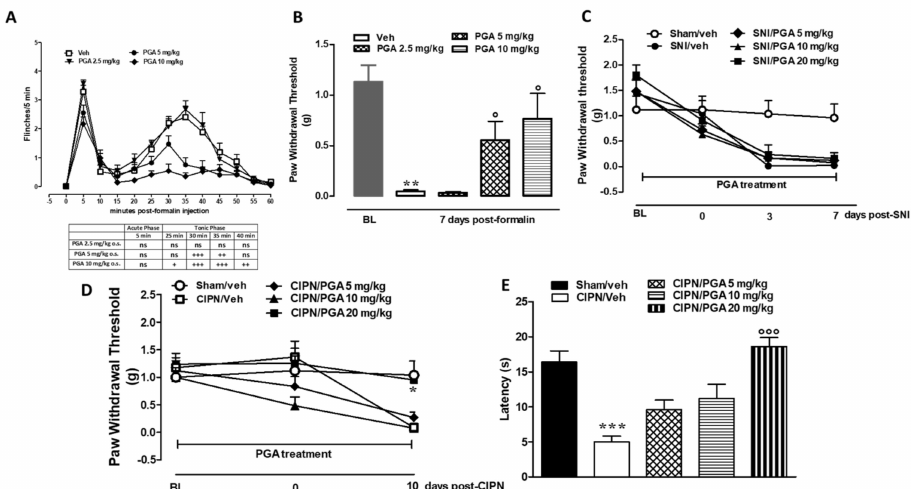
Figure 5. ( A , B ) Effect of PGA (2.5, 5 and 10 mg/kg os) in the formalin model of pain in mice. The total time of the nociceptive response was measured every 5 min and expressed in min and in repeated treatment on mechanical withdrawal threshold of the ipsilateral hind paw 7 days after formalin injection in mice. Modifications on withdrawal thresholds [expressed as applied force (g)] of hindpaw ipsilateral of SNI mice ( C ) after chronic injection of different doses of vehicle or PGA (5, 10 and 20 mg/kg, o.s.). Effect of PGA (2.5, 5, 10 and 20 mg/kg, os) on withdrawal thresholds and cold allodynia of hindpaw of CIPN mice ( D , E ). Data were expressed as mean ± SEM of mechanical withdrawal thresholds in grams. + ( p < 0.05), ++ ( p < 0.01) and +++ ( p < 0.001) indicate significant differences vs vehicle treatment in formalin injected mice. * ( p < 0.05), ** ( p < 0.01) and *** ( p < 0.001) indicate significant differences vs veh/saline-treated mice, ◦ ( p < 0.05) ◦◦◦ ( p < 0.001) indicate significant differences vs. vehicle treatment (Two-way ANOVA followed by Tukey’s and Bonferroni post hoc